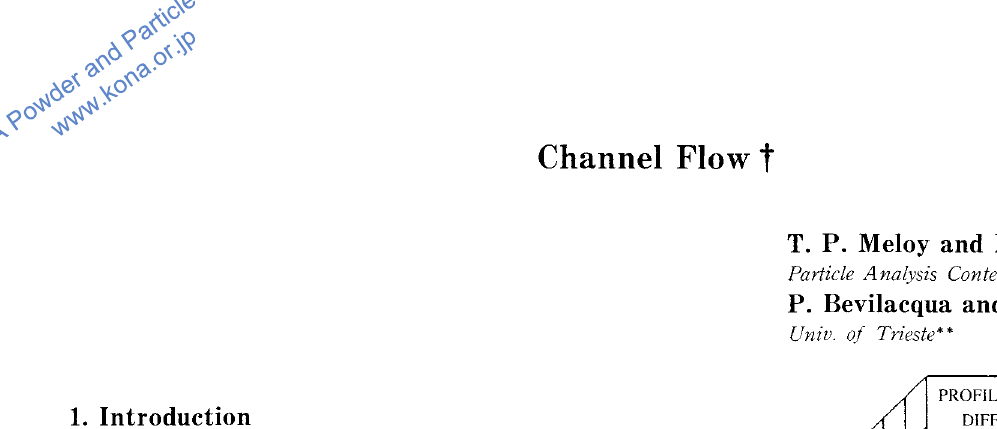
Fig. la Distributed flow after 300 seconds.